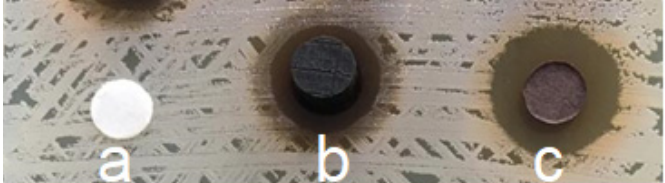
Figure 7. Antibiogram to test the antimicrobial properties of oak wood ( Quercus petraea ) against Staphylococcus aureus with the agar diffusion method: ( a ) an inert filter paper disc (negative control); ( b ) a wooden disc showing antimicrobial activity by forming a zone of inhibition and ( c ) a filter paper disc impregnated with wood extractives (10 mg extractive content extracted with methanol) showing antimicrobial activity by forming a zone of inhibition; © Authors.